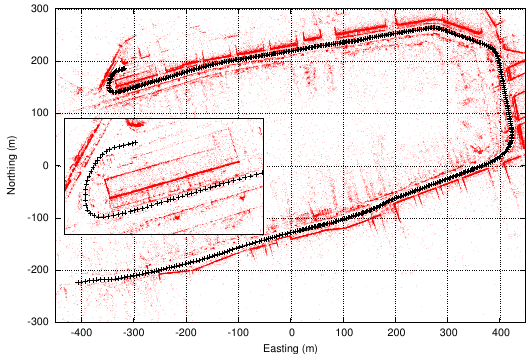
Figure 6. Aerial acquisition over mountainous area. Recovered trajectory (black line) and tie point positions (colored dots).